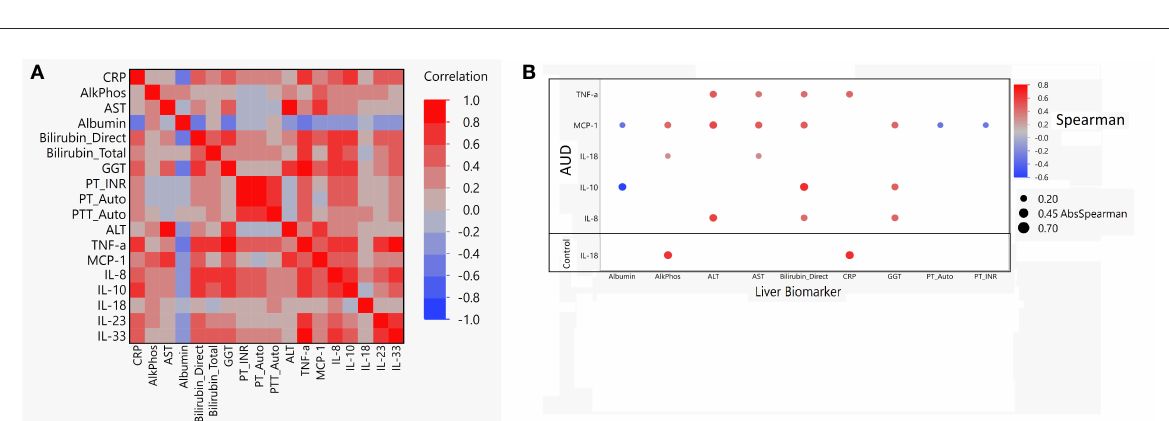
Multicollinearity was checked where tolerance and variance inflation factors (VIF) ranged from 0.577 to 0.907 in MCP-1, indicating no multicollinearity concerns among any of the